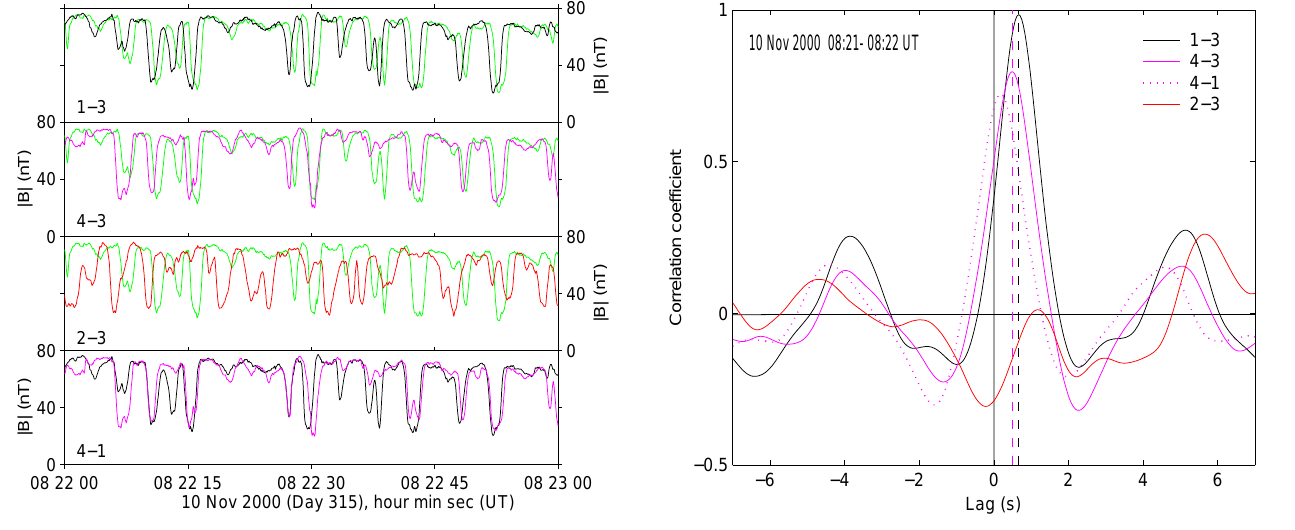
Fig. 10. The cross-correlation functions for the data shown in Fig. 9, in the same format as Fig.